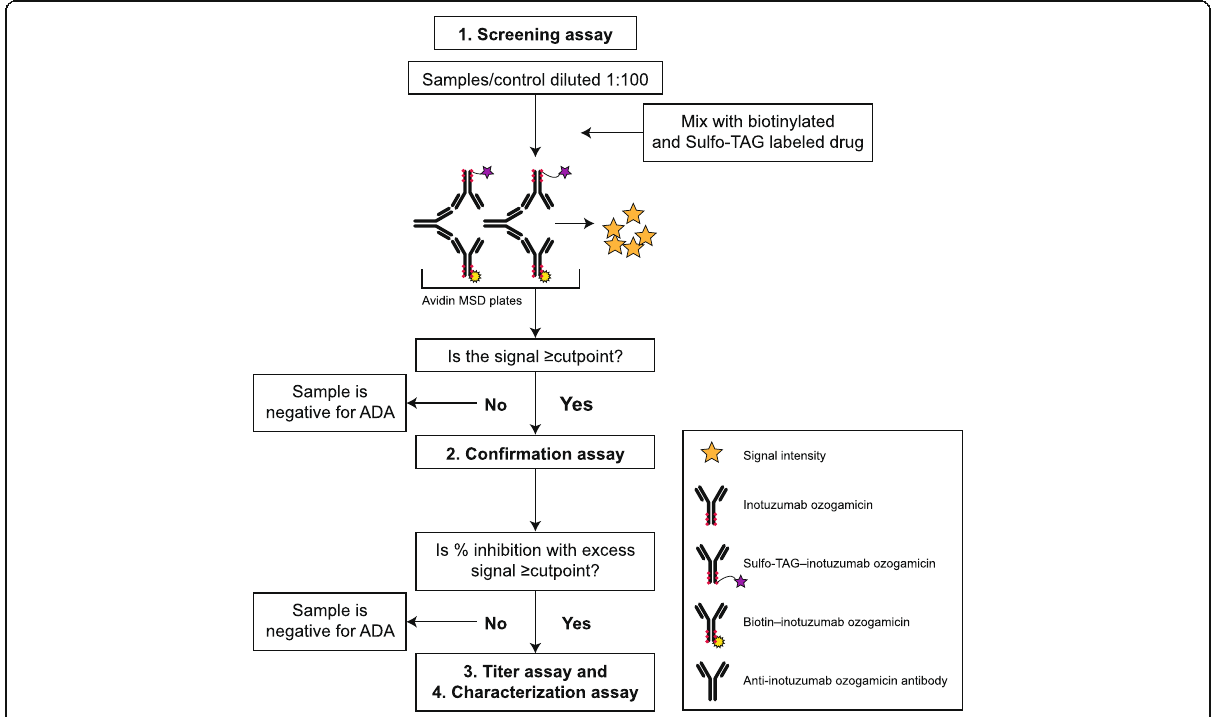
Fig. 2 ECL bioanalytical method for the detection of ADAs during ALL studies. ADA= anti-drug antibody; ALL = acute lymphoblastic leukemia; ECL = electrochemiluminescence; MSD = Meso Scale